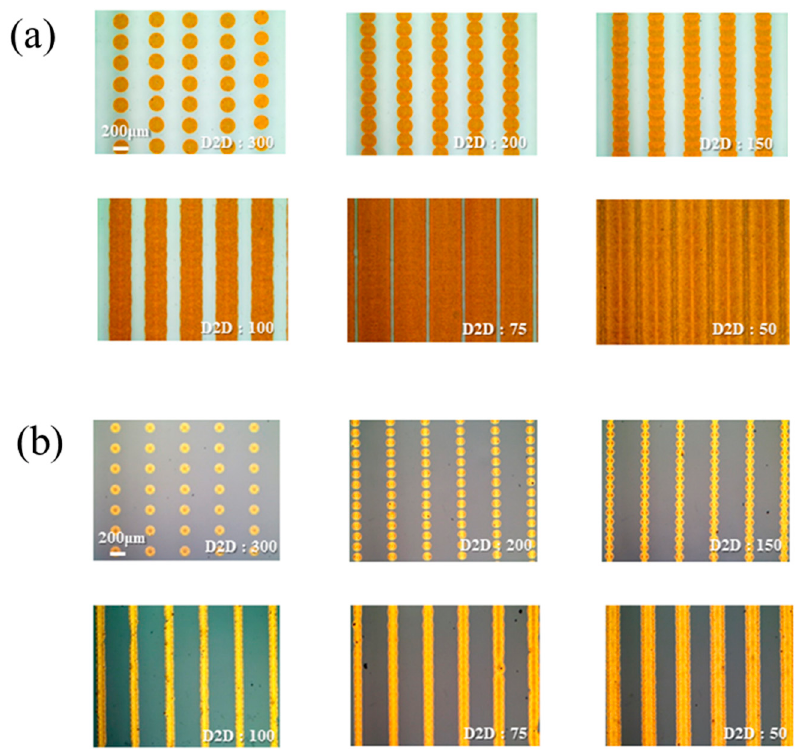
Figure 8. Ink-jet printed circuit according to D2D interval: ( a ) on a quartz glass substrate and ( b ) on photo-cured SiO 2 insulation layer.